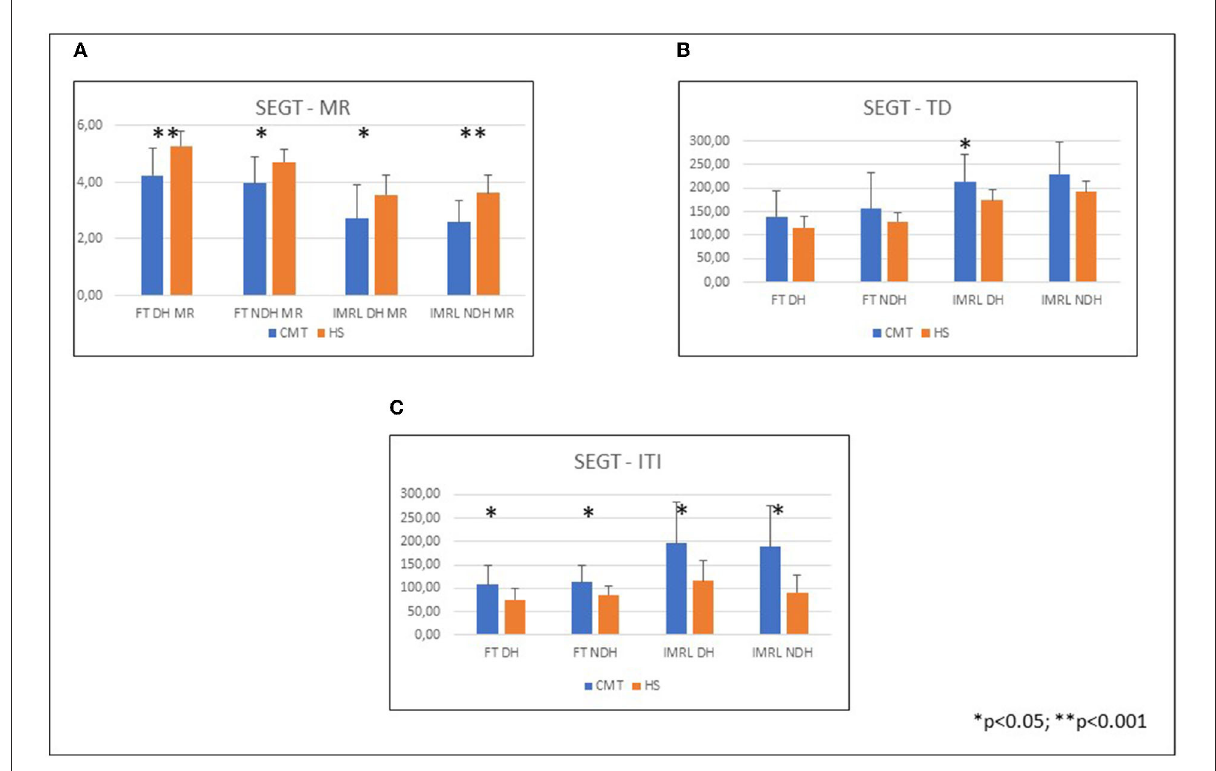
FIGURE2 Hand performances at SEGT; CMT patients compared to healthy subjects. (A) Mean and SD of the SEGT-MR in the different groups: FT DH CMT 4.19 ± 1; HS 5.28 ± 0.56; FT NDH CMT 3.96 ± 0.94; HS 4.72 ± 0.47; IMRL DH CMT 2.66 ± 1.15; HS 3.57 ± 0.66; IMRL NDH CMT 2.56 ± 0.80; HS 3.62 ± 0.59. (B) Mean and SD of the SEGT-TD in the different groups: FT DH CMT 139.91 ± 53.07; HS 116.17 ± 23.91; FT NDH CMT 155.74 ± 72.71; HS 128.76 ± 22.12; IMRL DH CMT 216.48 ± 55.52; HS 173.99 ± 20.47; IMRL NDH CMT 230.44 ± 55.52; HS 192.14 ± 19.99. (C) Mean and SD of the SEGT-ITI in the different groups: FT DH CMT 107.79 ± 38.63; HS 75.72 ± 22.86; FT NDH CMT 112.33 ± 33.93; HS 85.32 ± 17.17; IMRL DH CMT 202.02 ± 89.47; HS 116.22 ± 41.37; IMRL NDH CMT 198.74 ± 114.88; HS 91.03 ± 31.98. CMT, Charcot-Marie-Tooth; HS, Healthy subjects; SEGT, sensor-engineered glove test; MR, movement rate; TD, touch duration; ITI, inter-tapping interval; DH, dominant hand; NDH, non dominant